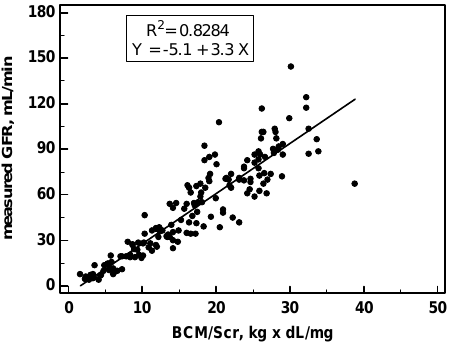
Figure 5. Correlation between glomerular filtration rate (GFR) and the ratio of body cell mass (BCM, kg) over serum creatinine (SCr, mg/dL).